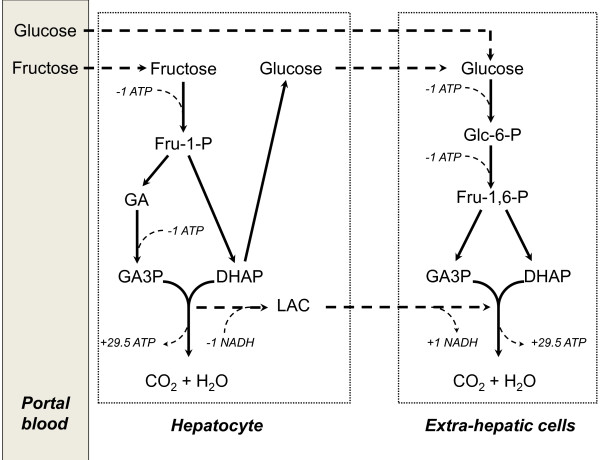
Metabolic steps accounting for a lower efficiency of fructose compared to glucose. Fructose conversion into glucose in the liver, followed by glucose oxidation in extrahepatic cells requires the use an additional 2 ATPs compared to the direct oxidation of blood glucose; this is associated with a higher ATP used/ATP synthesized ratio, and thus to a higher energy cost of net ATP gained. F-1-P: fructose-1-phosphate; G-6-P: glucose-6-phosphate; DHAP: dihydroxyacetone-phosphate; GAP: glyceraldehyde-phosphate; GAH: glyceraldehyde; LAC: lactic acid.